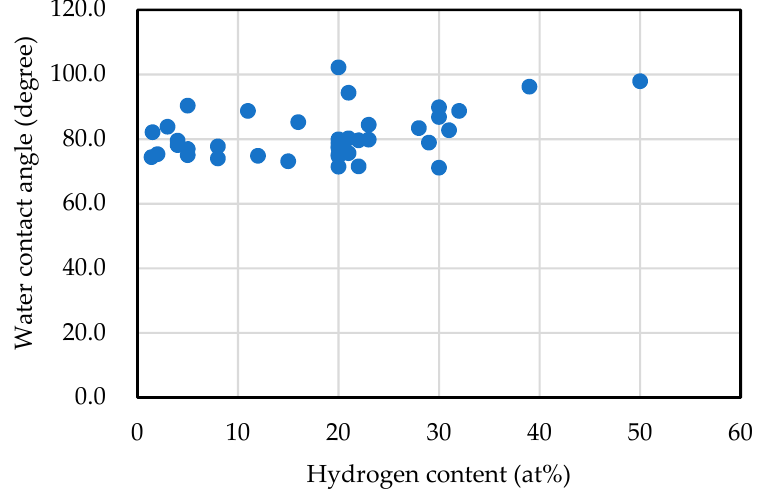
Figure 4. Water contact angle vs. hydrogen content of amorphous carbon films.